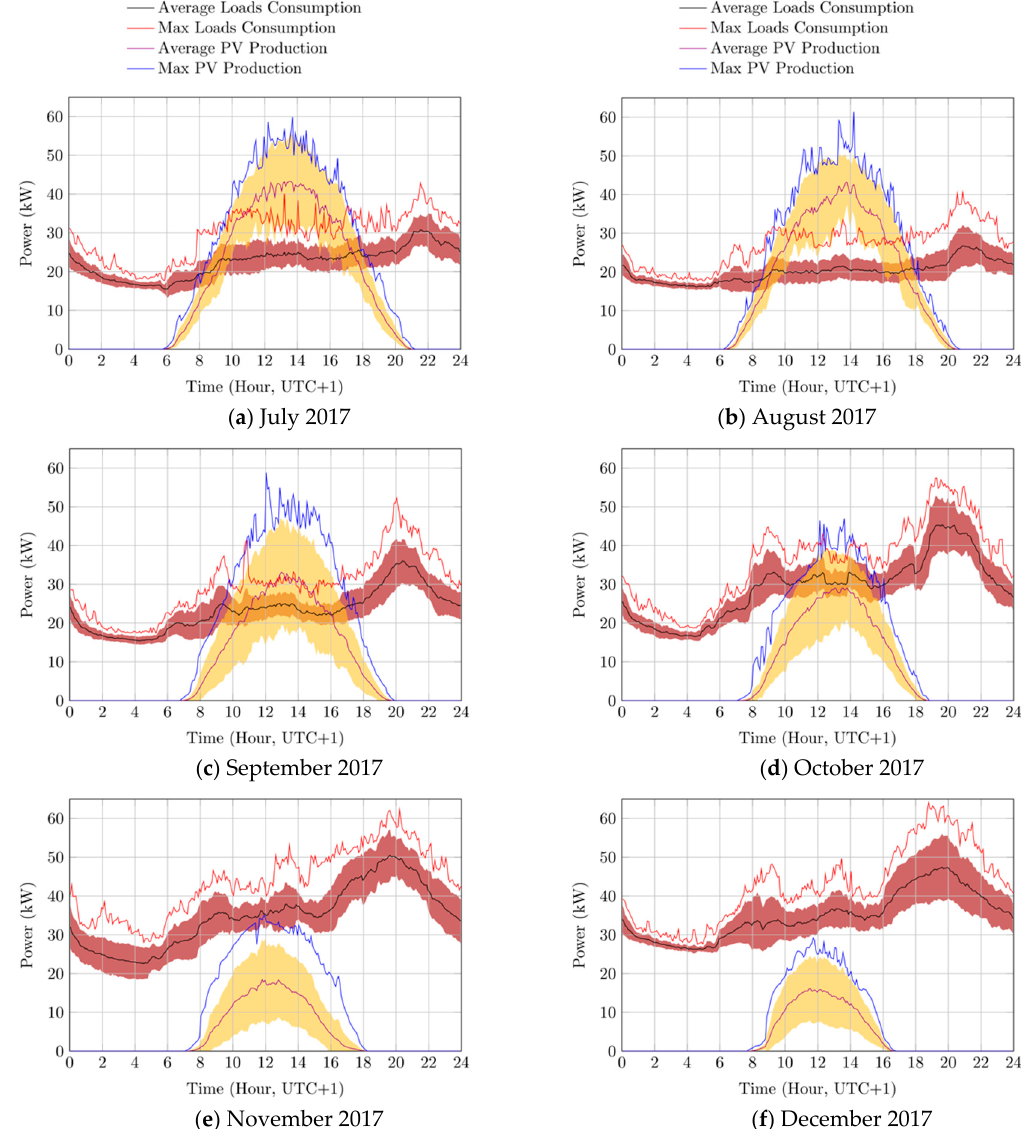
Figure 2. Monthly average and peak power data of photovoltaic (PV) production and user’s loads recorded from July to December 2017, as depicted from sub-figure ( a ) to sub-figure ( f ), respectively. The yellow and red area represent the standard deviation of PV and loads data, respectively. UTC: Universal Time Coordinated.